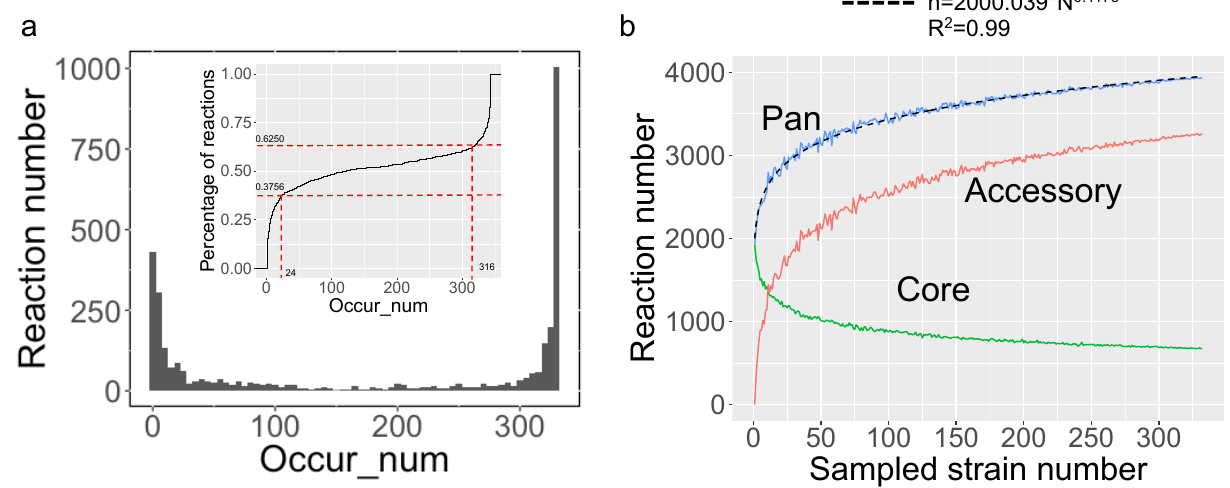
Figure 3. Statistical analysis of the pan-draft metabolic models: ( a ) Distribution of reactions based on their occurrence number in 332 yeast species plus 11 outgroup fungal species. The small graph in ( a ) represents the cumulative density of reactions based on its existence across 332 yeast species plus 11 outgroup fungal species; ( b ) profiles of pan-, core, and accessory reactions along with the number of sampled yeast species. The dotted line represents the predicted pan-reaction number from the Heaps’